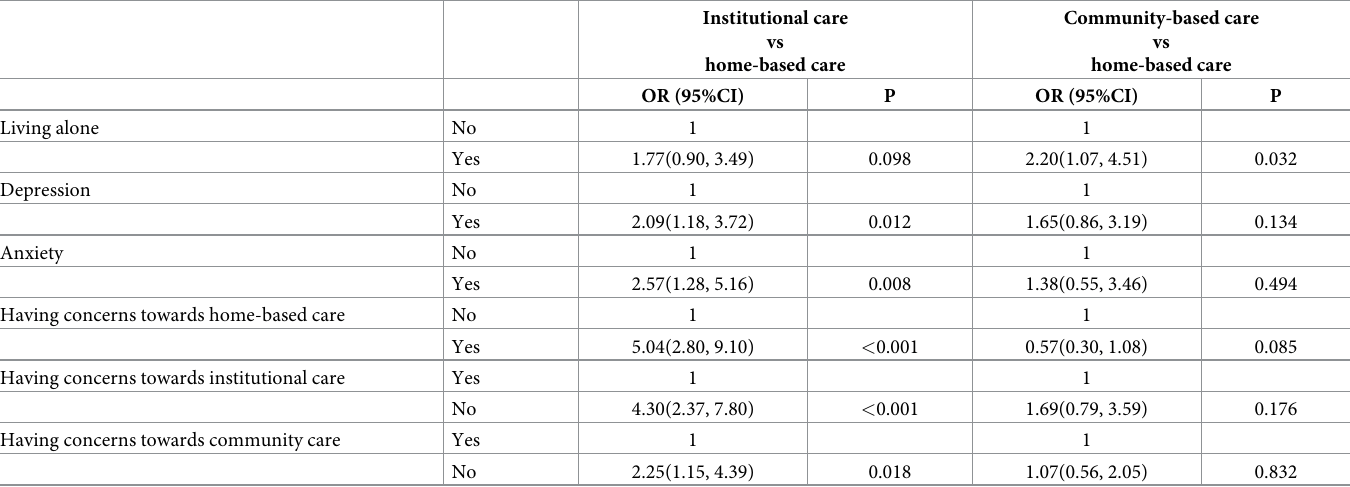
Table 4. The results of univariate logistic regression.